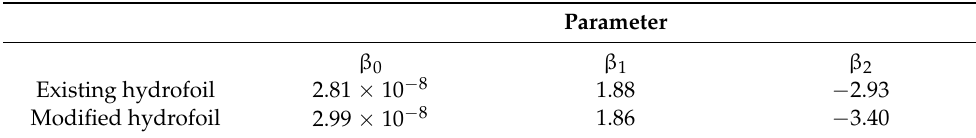
Table 3. Cavitation length model parameters for modelled cavitation length L.